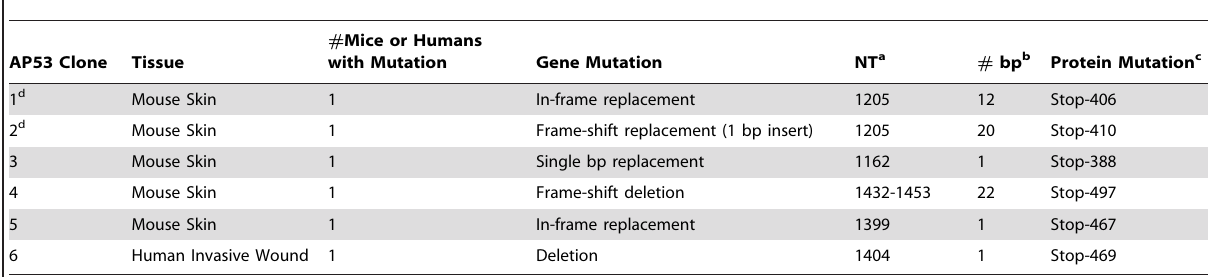
Table 3. Mutations found in covS gene of GAS strain AP53/ covS + during infection.